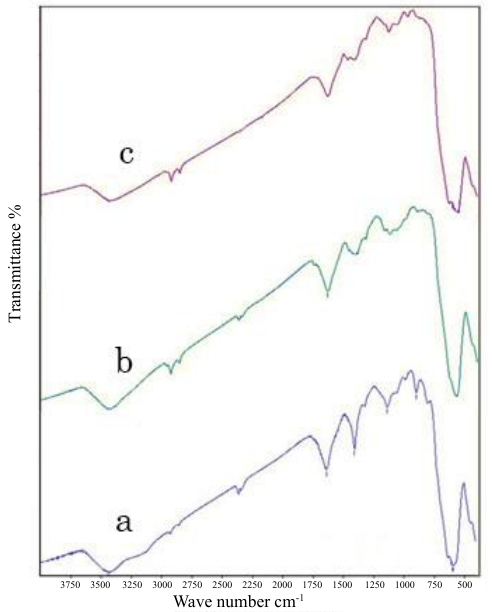
Fig. 4. Langmuir isotherms:(A) uncoated Fe (B) BKC-coated Fe O 3 4